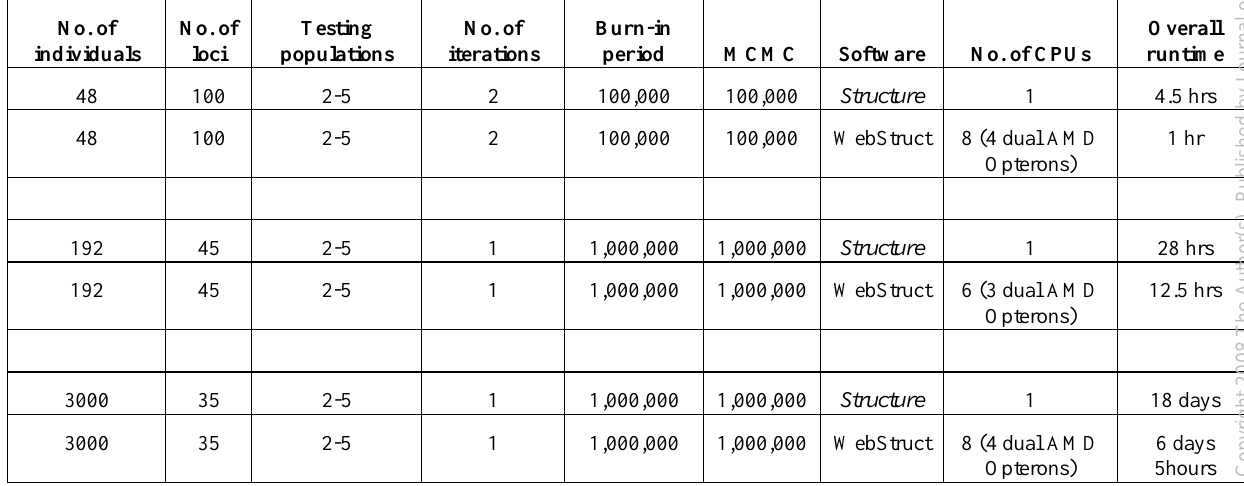
Table 1: Comparison of overall runtime to process various number of individuals, loci, testing populations, iterations and burn-in period and MCMC running Structure on a desktop as opposed to a cluster of three or four 64-bit dual AMD opteron nodes of the Paracel high performance linux